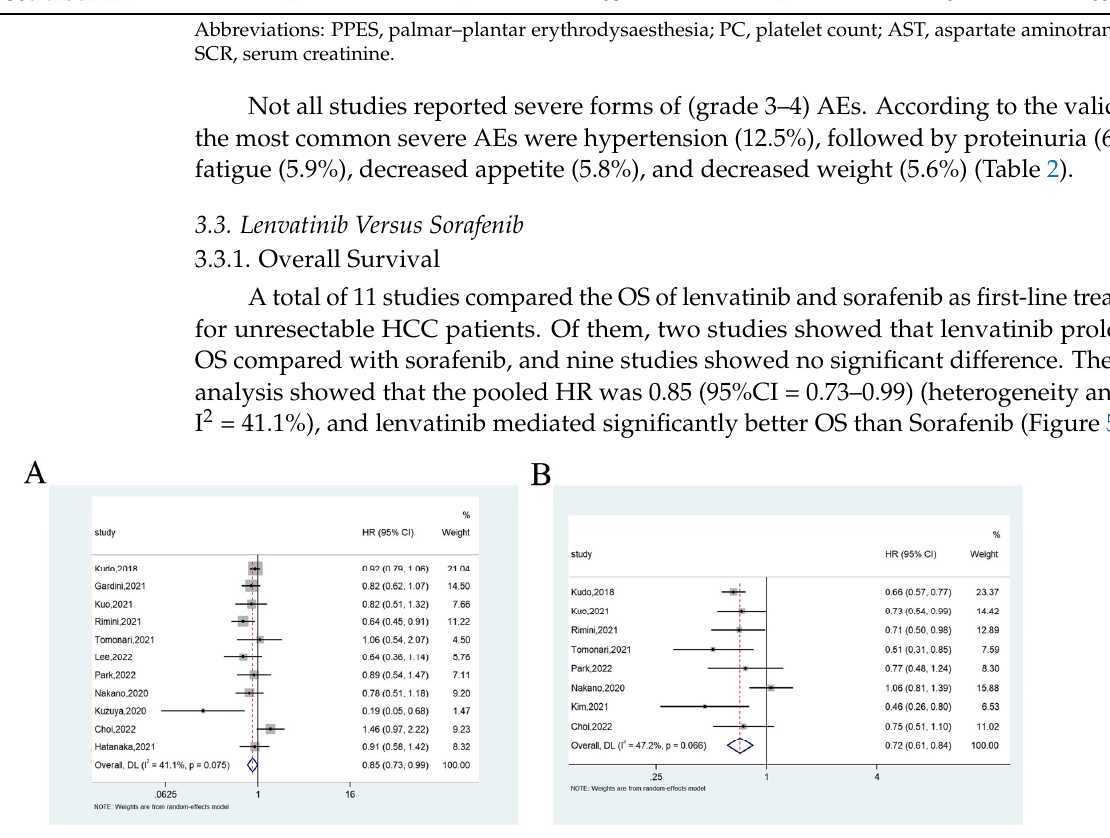
Figure 5. Forest plots of the OS ( A ) and PFS ( B ) associated with lenvatinib vs.